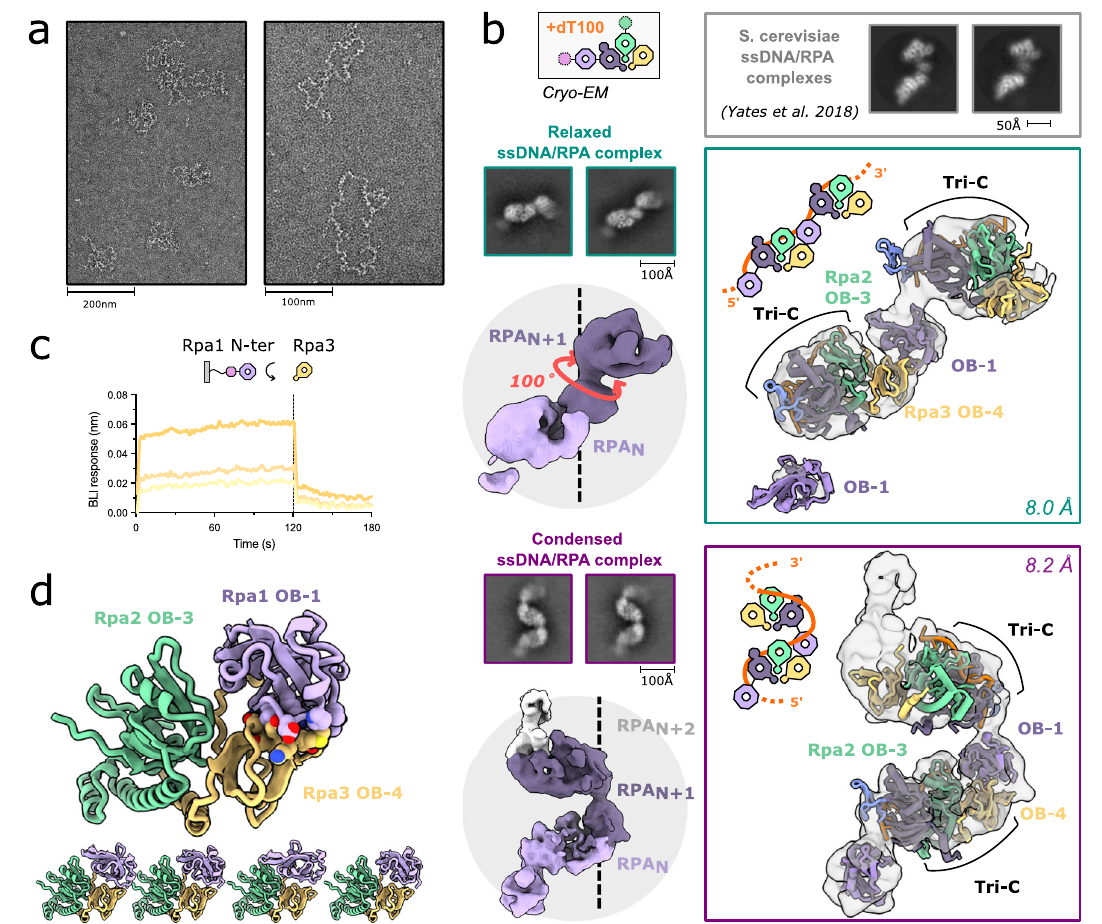
Fig. 3 | Structural basis for the assembly of multiple PabRPA molecules on ssDNA. a Negative-staining microscopy of PabRPA bound to M13 ssDNA plasmid. The experiment was repeated three times independently. b Cryo-EM structures of PabRPA bound to a poly-dT100 reveals two interacting modes. Two independent datasets were collected and revealed different levels of condensation of ssDNA- PabRPA complexes: a “ relaxed ” one and a “ condensed ” one. Crystal structures of